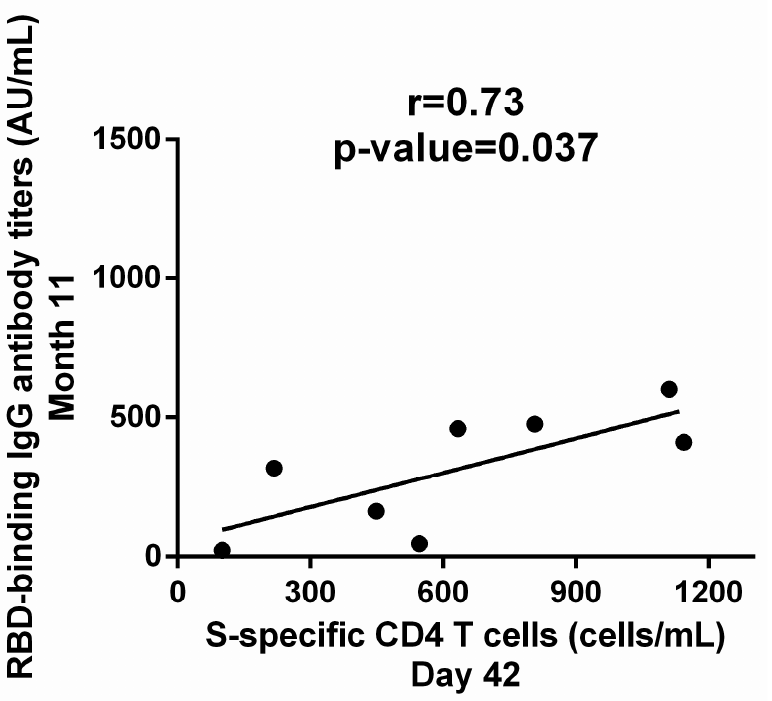
Figure 5. Correlation of cellular immunity and humoral immunity to BNT162b2. Cellular immunity after the completion of the primary dual immunization is correlated with the recall response to anamnestic vaccine dose, as S-specific CD4 T cells on D42 were correlated with RBD-binding IgG antibody titers on Month 11. Correlation was estimated with the Pearson r correlation coefficient and significance was calculated by a two-tailed p value. Each dot represents a serum sample. Although mRNA vaccines against SARS-CoV-2 are considered highly effective for the prevention of severe COVID-19, current evidence suggests a heterogeneity of the immune response to BNT162b2 immunization, as studies have identified vaccinated individuals who do not mount efficient immune responses [5]. We postulated that humoral and cellular immunity to vaccination are induced in a coordinated manner. Therefore, we investigated whether “low responders” and “high responders” based on antibody titers on D21 also displayed distinct cellular and anamnestic immune responses. For that purpose, we set a cut-off point at the lower 25% of the RBD-IgG range in our cohort and stratified subjects to either the high- or low-responder group. After stratification according to humoral response following the first BNT162b2 dose, three subjects were stratified into high responders and eight subjects were stratified into low responders. Total S-specific and S-specific memory CD4 T cells differed significantly on D21 (median values 84.5 vs. 762.3 cells/mL, p < 0.05; 147 vs. 827 cells/mL, p < 0.05 respectively) and D42 (median values 333.3 vs. 1144 cells/mL, p < 0.05; 308.8 vs. 834 cells/mL, p < 0.05, respectively) (Figure 6). Therefore, we observed a vaccine-induced coordinated immune response, as vaccinated individuals who achieved higher antibody titers after the first vaccine dose also displayed a more robust cellular response. RBD-IgG titers following the third dose also differed between ‘low’ and ‘high’ responders (GMT 193.3 vs. 450.4 AU/mL), although these differences did not reach statistical